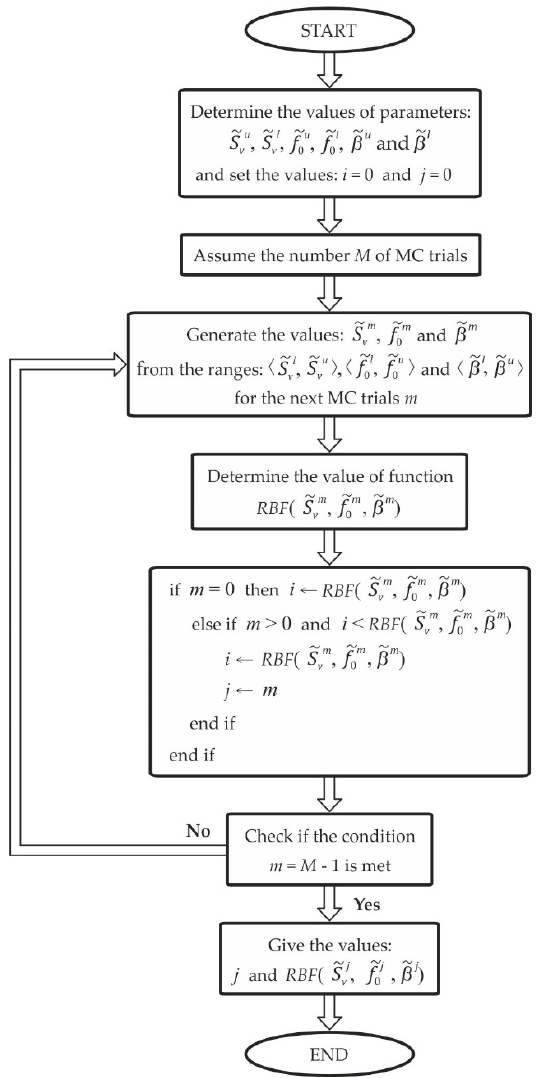
Figure 3. Block diagram of the Monte Carlo (MC)-based procedure for determining the UAE RBF ( max ) .